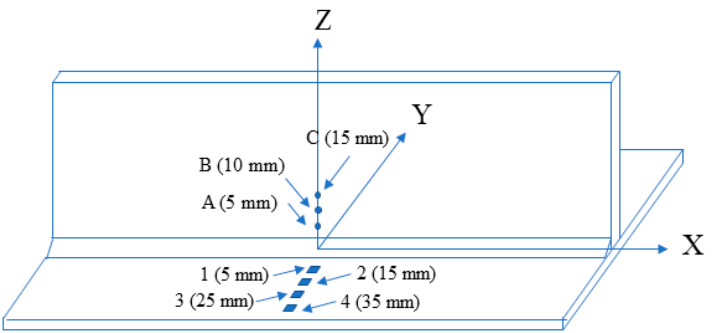
Figure 3. Measuring points of temperature and stress field.